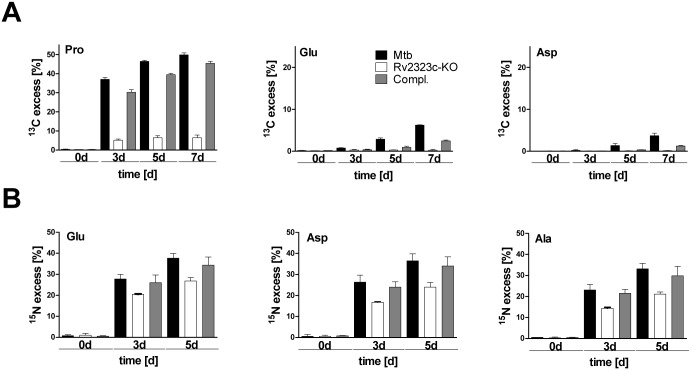

13C- or 15N- excess of labeled amino acids in a Rv2323c knockout strain grown with [U-13C6]arginine (A) or [U-15N4]arginine (B).Mtb wild type (Mtb), Rv2323c knockout mutant (Rv2323c-KO), and the Rv2323c knockout mutant complemented with the Rv2323c wild type gene (Compl.) are shown. Bacteria were cultured in minimal medium with glucose and glycerol as carbon sources and with either 5 mM of a 1:1 mixture of [U-13C6]arginine and unlabeled arginine as sole nitrogen source (A) or with 5 mM of a 1:1 mixture of [U-15N4]arginine and unlabeled arginine as sole nitrogen source (B). A) The 13C-excess of proline and other selected amino acids such as glutamate and aspartate is shown after 0, 3, 5, and 7 days of growth.13C-Excess at day 0 was <1%. B) The 15N-excess of glutamate and other selected amino acids such as aspartate and alanine is shown after 0, 3, and 5 days of growth (for more details see S3 Table). 15N-Excess at day 0 was < 1%. Mean values and standard deviations are shown for two independent biological experiments each measured in triplicate.